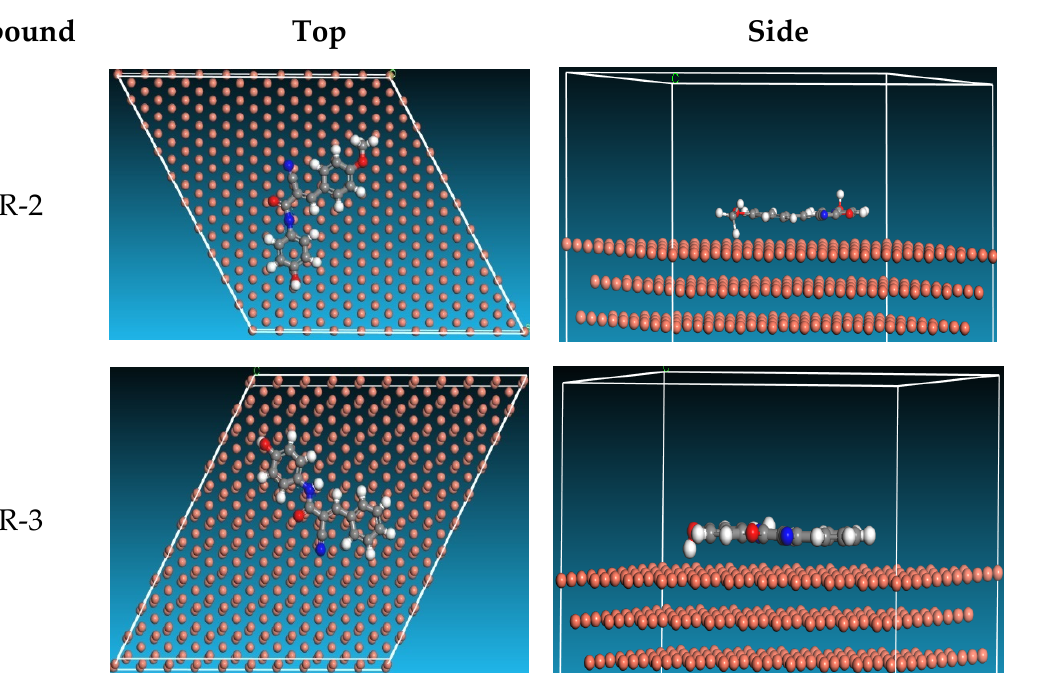
Figure 17. Adsorption of acrylamide compounds on Cu surface. Table 9. Monte Carlo simulation parameters of adsorption of acrylamide compound on Cu (1 1 1) surface.